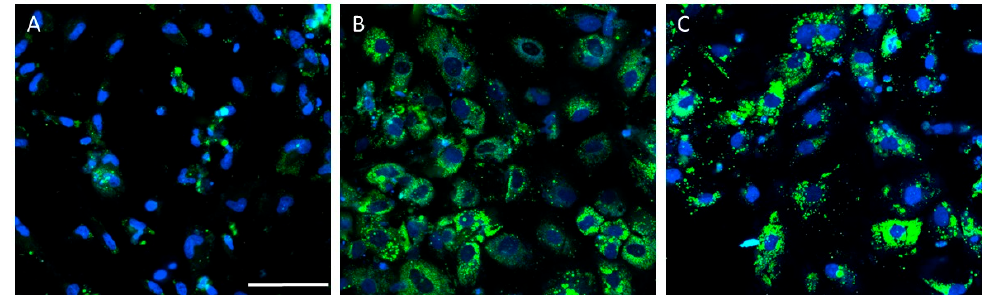
Figure 3. Drug-induced lipid accumulation in the hepatocyte-like cells (HLCs) derived from induced-pluripotent stem cells (iPSCs) from a healthy donor. Representative images of untreated HLCs ( A ), and HLCs treated with valproate ( B ) or amiodarone ( C ), are also shown. Nuclei were stained with Hoechst 33342 (blue) and neutral lipids with BODIPY 493 (green). Scale bar (50 µm) applies to all images.